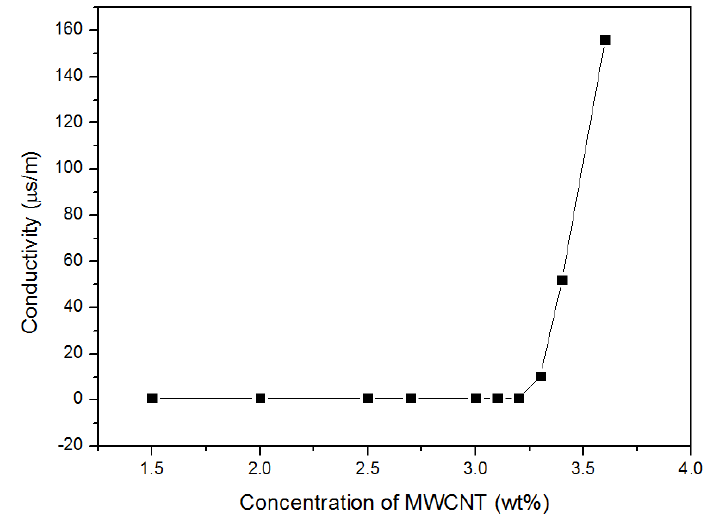
Figure 3. The conductivity of MWCNT/PDMS composite as a function of the concentration of MWCNT.